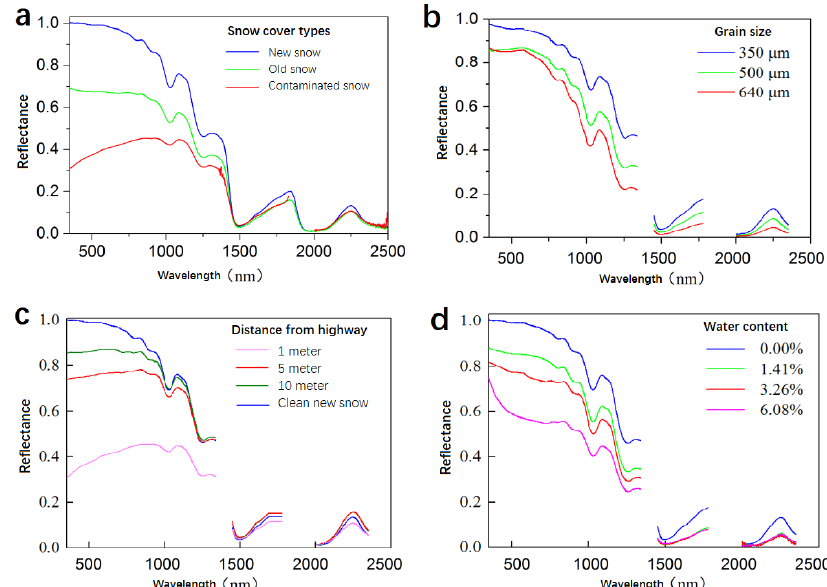
Figure 8. Surface reflectance measured with the ASD FieldSpec4 instrument. ( a ) Surface reflectance of new, uncontaminated aging, and contaminated snows; ( b ) Snow surface reflectance for three varying grain sizes; ( c ) Surface reflectance of new and contaminated snows at different distances from the highway; ( d ) Snow surface reflectance for different water contents. Table 2. The candidate SAP indexes library with respective calculation formulas.